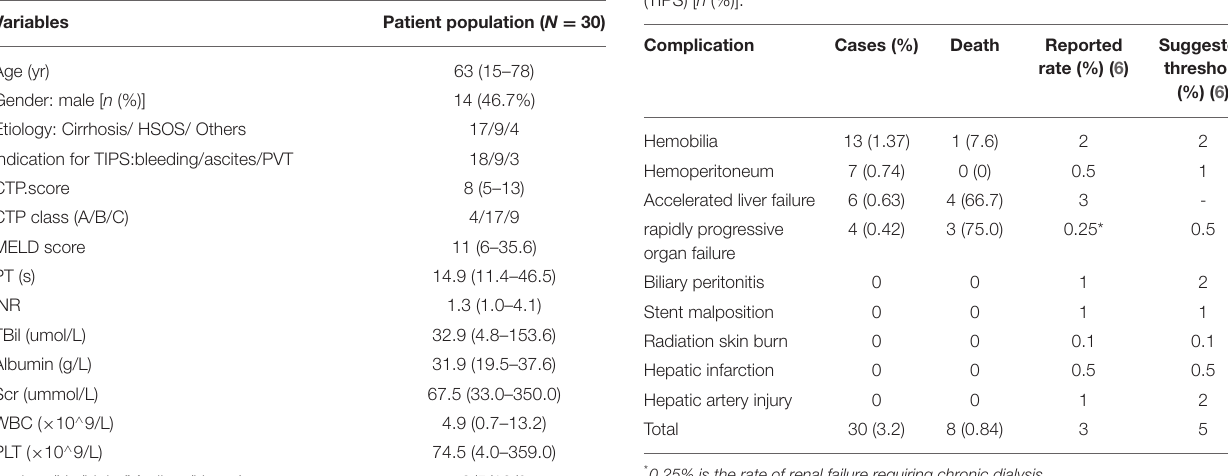
TABLE 1 | Patients’ clinical characteristics. TABLE 2 | Major complications of transjugular intrahepatic portosystemic shunt (TIPS) [ n (%)].